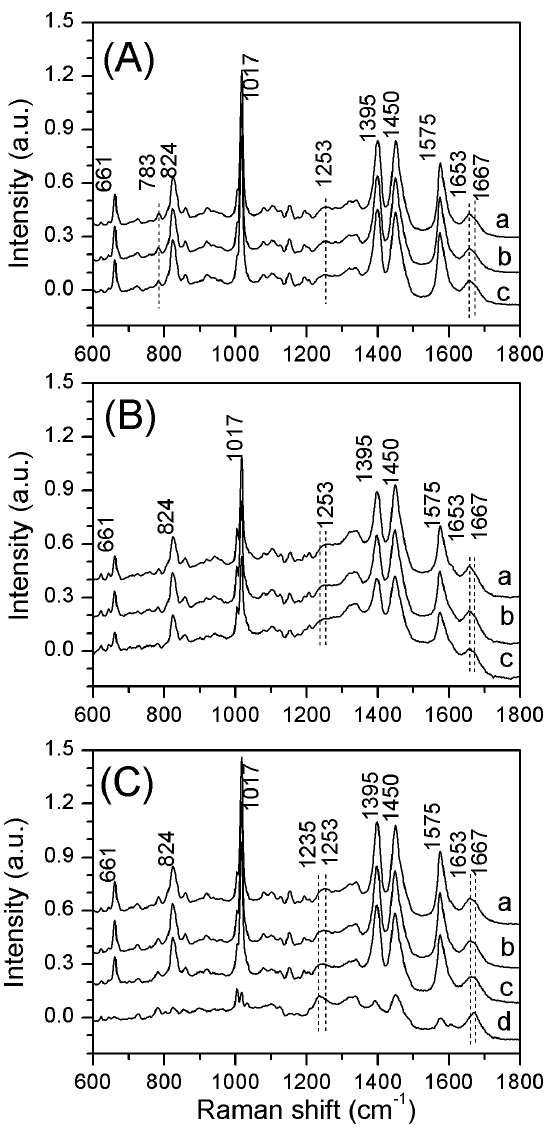
Figure 1. Raman spectra of individual spores. Raman spectra of individual G.stearothermophilus (A), B.subtilis (B), and B.cereus spores (C), measured at 25 u C (curve a), 65 u C (curve b) and 95 u C (curve c), respectively. Curve d in Fig. 1(C) is the Raman spectrum of single B. cereus spores that had lost their CaDPA at 95 u C. All the spectra were averages from 30 individual spores determined as described in Methods. The dotted lines are the protein bands of amide I (1653/ 1667 cm 2 1 ) and amide III (1253 cm 2 1 ), respectively.